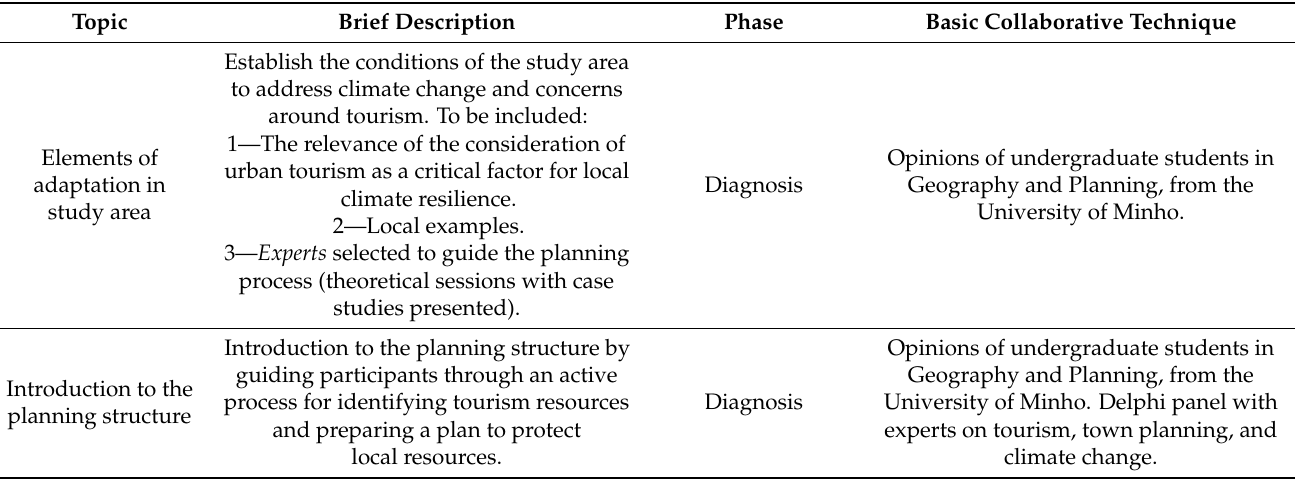
Table 2. TIP model implementation—research topic, phase and collaborative practice used .